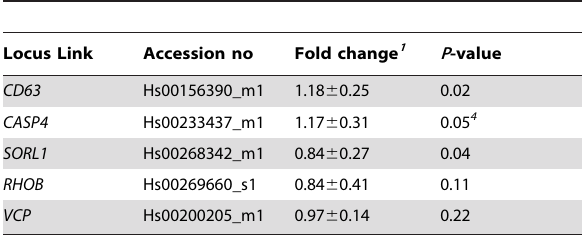
Table 3. Individual messenger RNA measurements in the n-3 fatty acid